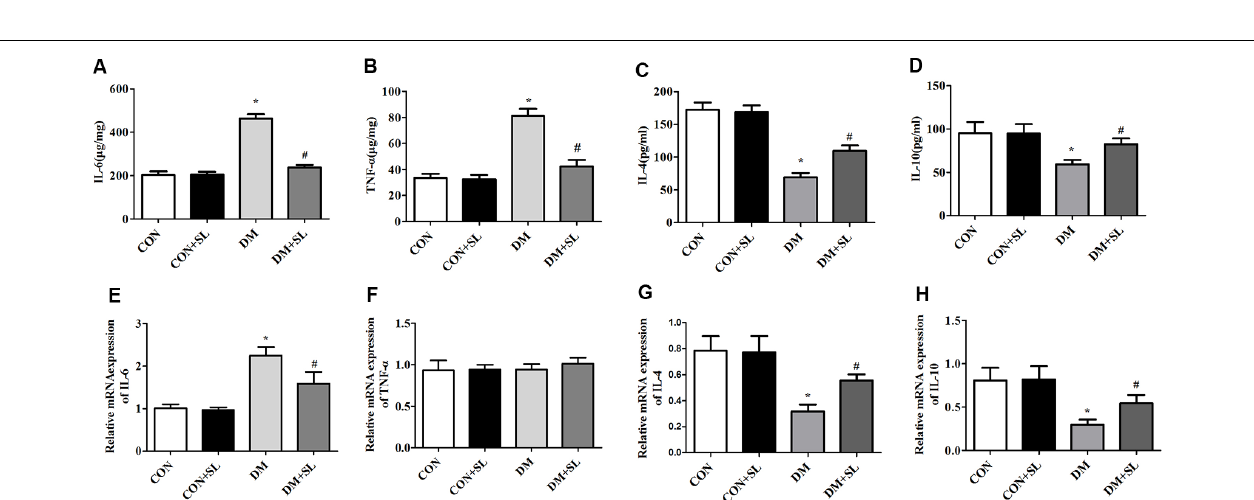
Frontiers in Aging Neuroscience |